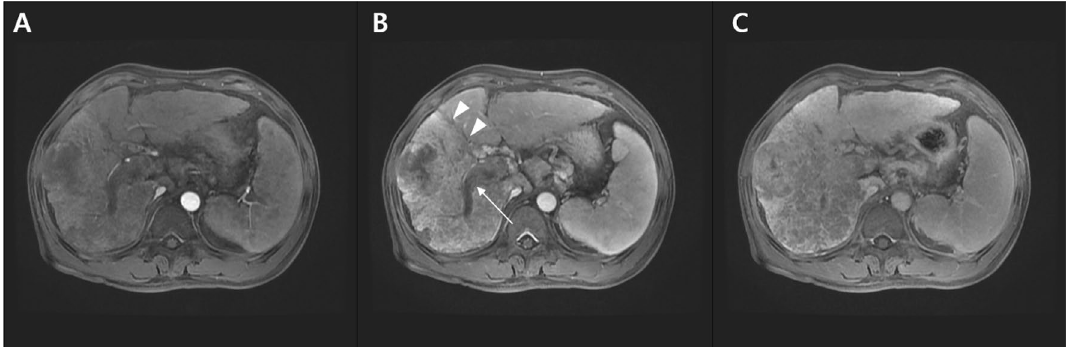
Figure 1. MRI image of a patient with cancer. Gadoxetic acid disodium-enhanced liver MRI images of a patient with HCC. ( A ) A huge mass replacing the right lobe of the liver in the arterial phase. ( B ) The mass (arrowhead) and portal vein thrombosis (arrow) are more prominent in the portal phase. ( C ) The mass shows washout in the venous